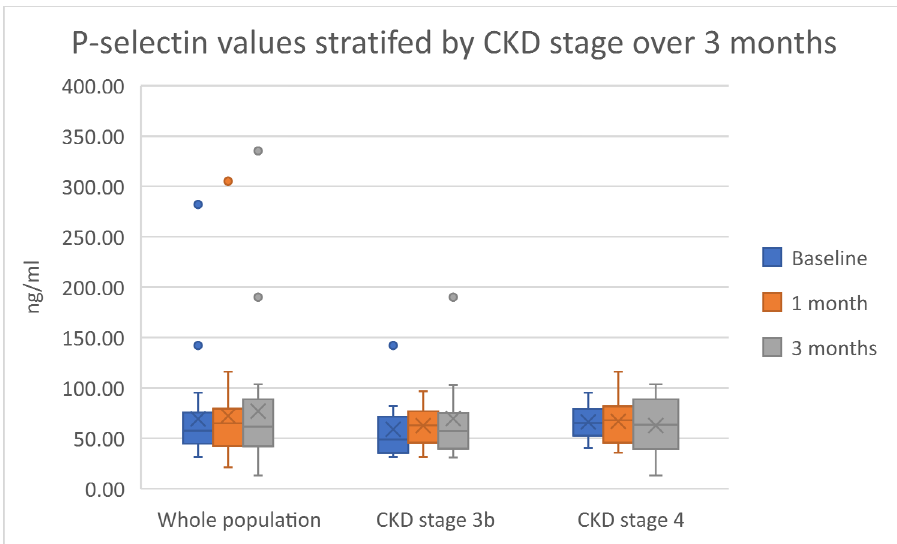
Figure 3. A boxplot representation of the data relevant to P-selectin. Dots represent outliers in the